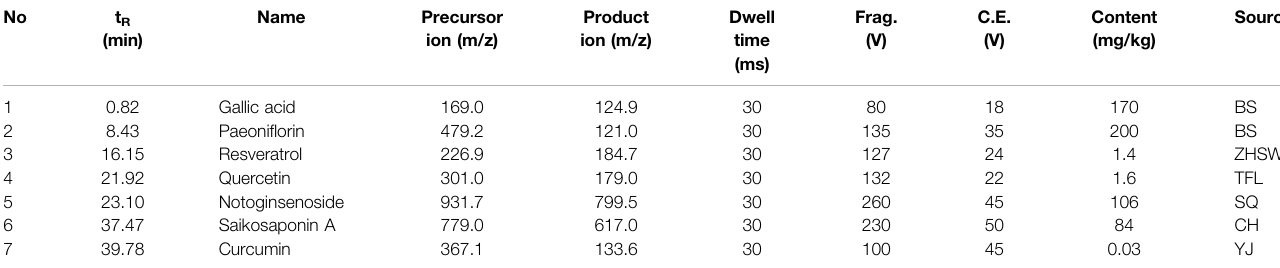
TABLE 1 | Multiple reaction monitoring (MRM) conditions and the contents of seven components in